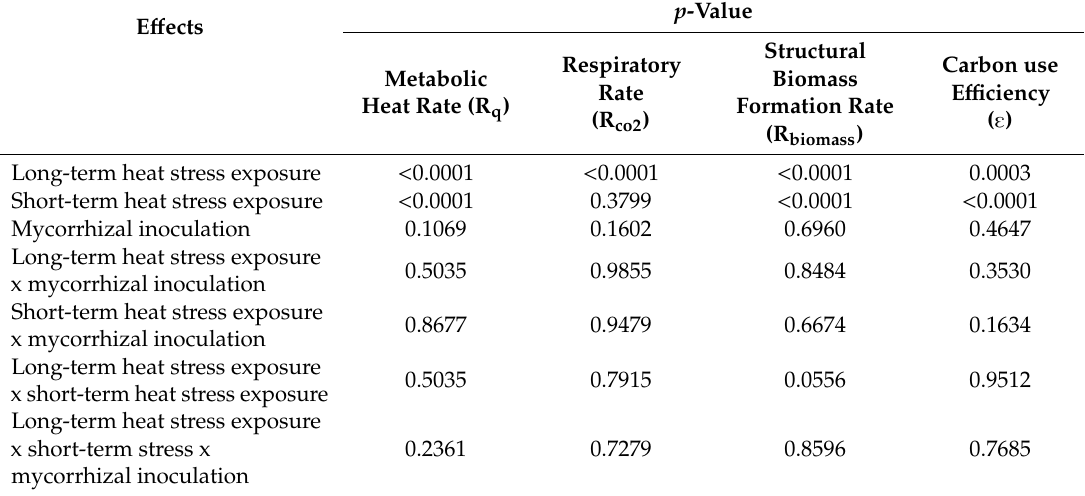
Table 4. P -values of the test for the e ff ects of the di ff erent factors and their interactions. Statistical analysis was done by fitting a linear model considering three fixed factors (mycorrhizal inoculation short-term heat stress and long-term heat stress), their interaction, and an error covariance matrix allowing correlation among observations from the same plant exposed to the di ff erent treatments. Significant e ff ect, p -value < 0.05. E ff